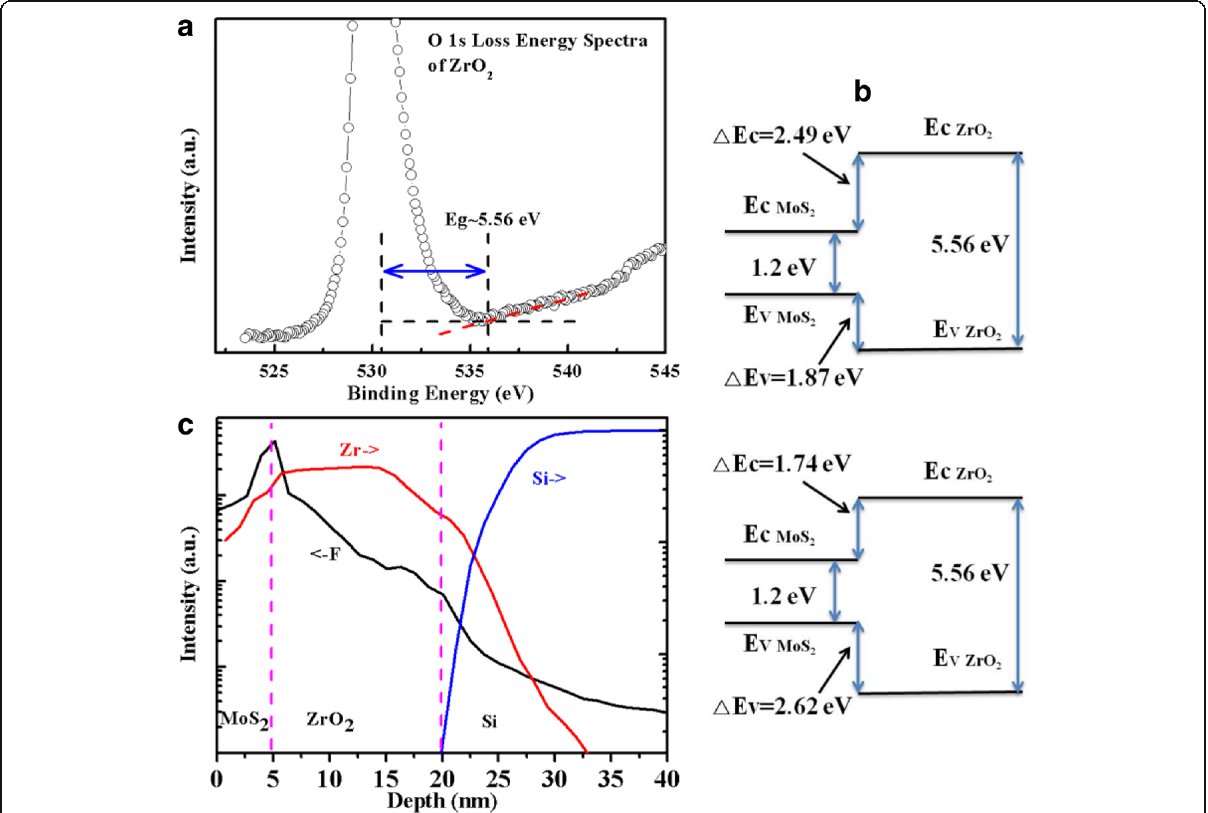
Fig. 3 a O 1 s photoelectron energy loss spectra for the ZrO 2 oxide. b The schematic structure of the energy band alignment at the MoS 2 /ZrO 2 interface without (top) and with (bottom) CHF 3 plasma treatment. c The SIMS depth profiles (Si, Zr, and F) for the sample with CHF 3 plasma